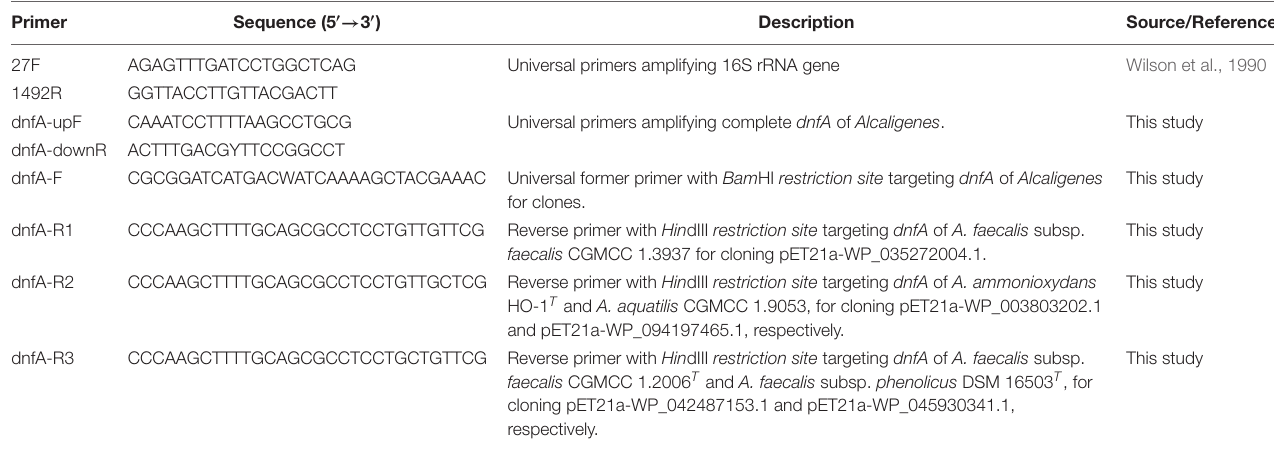
TABLE 3 | Primers used in this